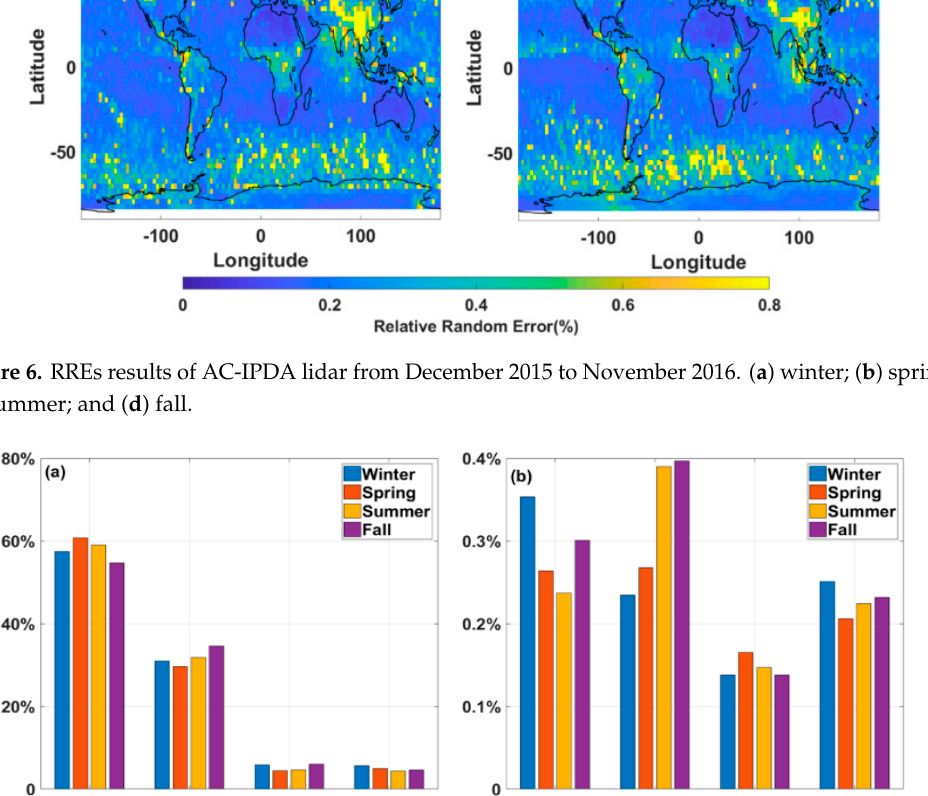
Table 3. Summary results of various systematic errors of AC ‐ IPDA lidar. Category